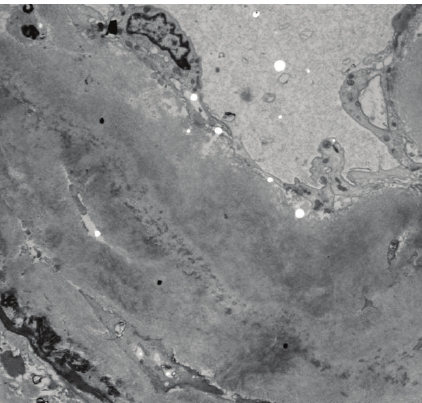
Figure 4: Electron microscopy picture showing a greatly thickened renal vessel wall with accumulation of fibrils.